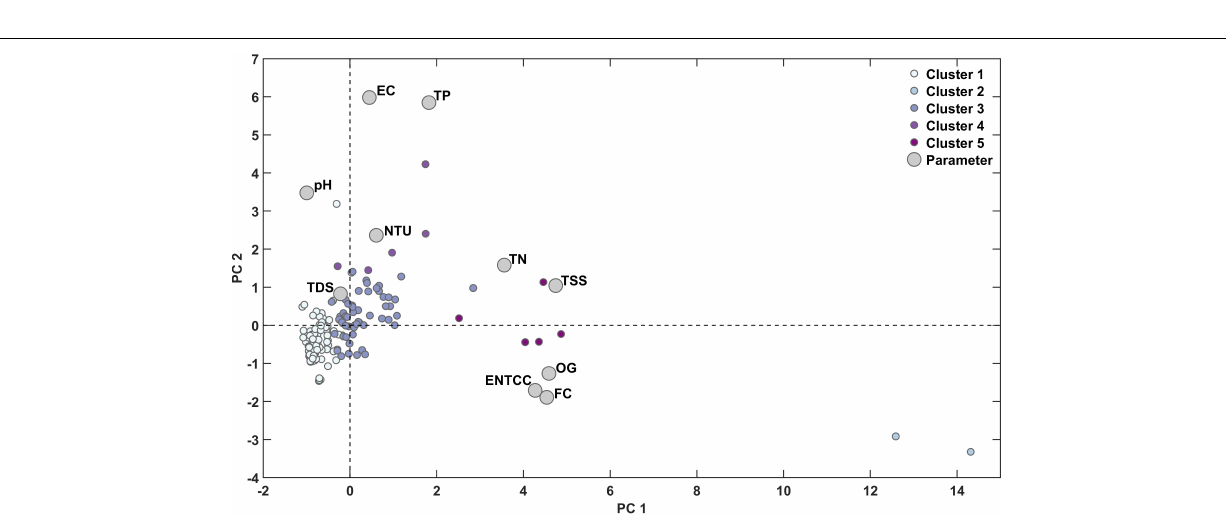
Frontiers in Marine Science |